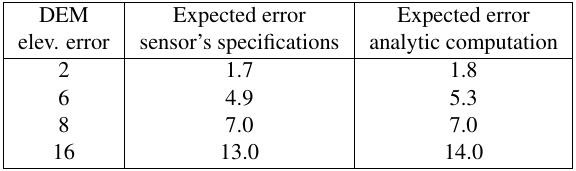
Table 2: The expected planar error (m) for incidence angle 50 ◦ .